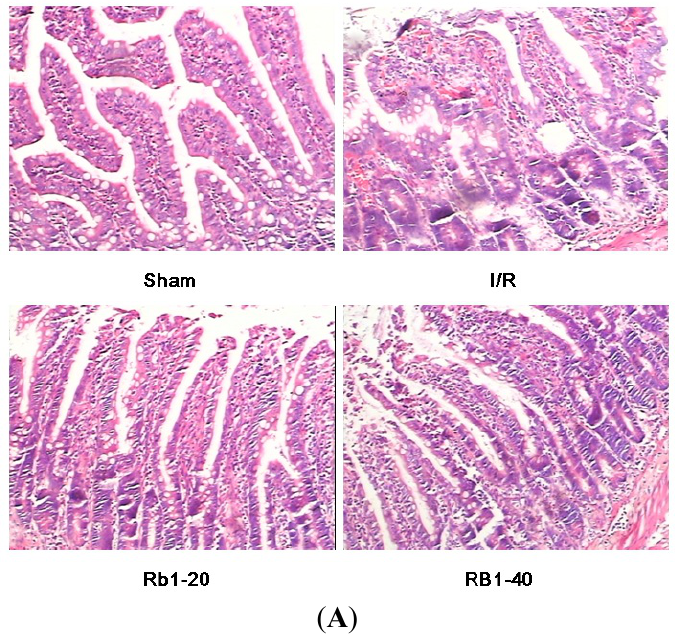
Figure 2. ( A ) Effects of Rb1 on intestinal injury after intestinal I/R. (HE ×400); ( B ) Intestinal pathological scores of different